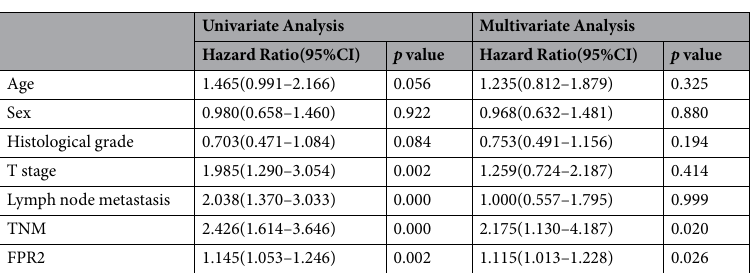
Table 2. Univariate and Multivariate Analysis of the effect of FPR2 on